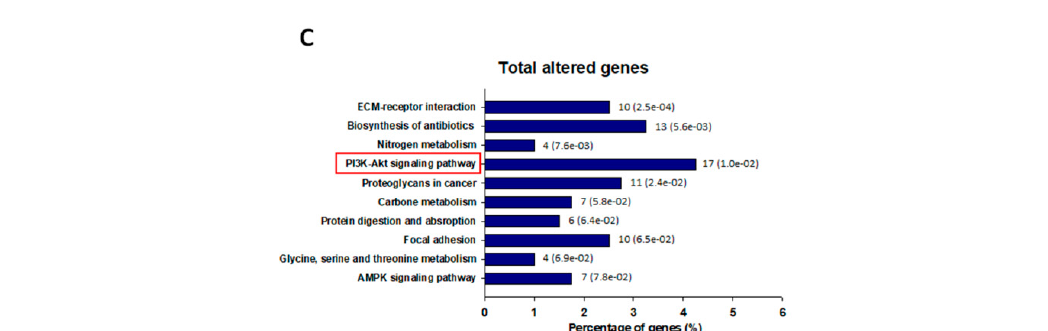
Figure 3. Top 10 altered pathways enriched in the Kyoto Encyclopedia of Genes and Genomes (KEGG) pathway analysis of A549/ADR cells. Pathways significantly enriched in ( A ) up-regulated genes, ( B ) down-regulated genes, and ( C ) total DEGs in A549/ADR cells vs. A549 cells analyzed in KEGG using DAVID. The horizontal axis shows the percentage of annotated genes compared to the total gene number. The vertical axis shows the pathways analyzed by KEGG analysis using DAVID. The pathways are organized by their p -values. The number shown on the right of each bar represents the number of genes, and the number in the parentheses represents the p -value. The red frame indicates the significant enrichment of the PI3K–Akt pathway from the KEGG pathway analysis.